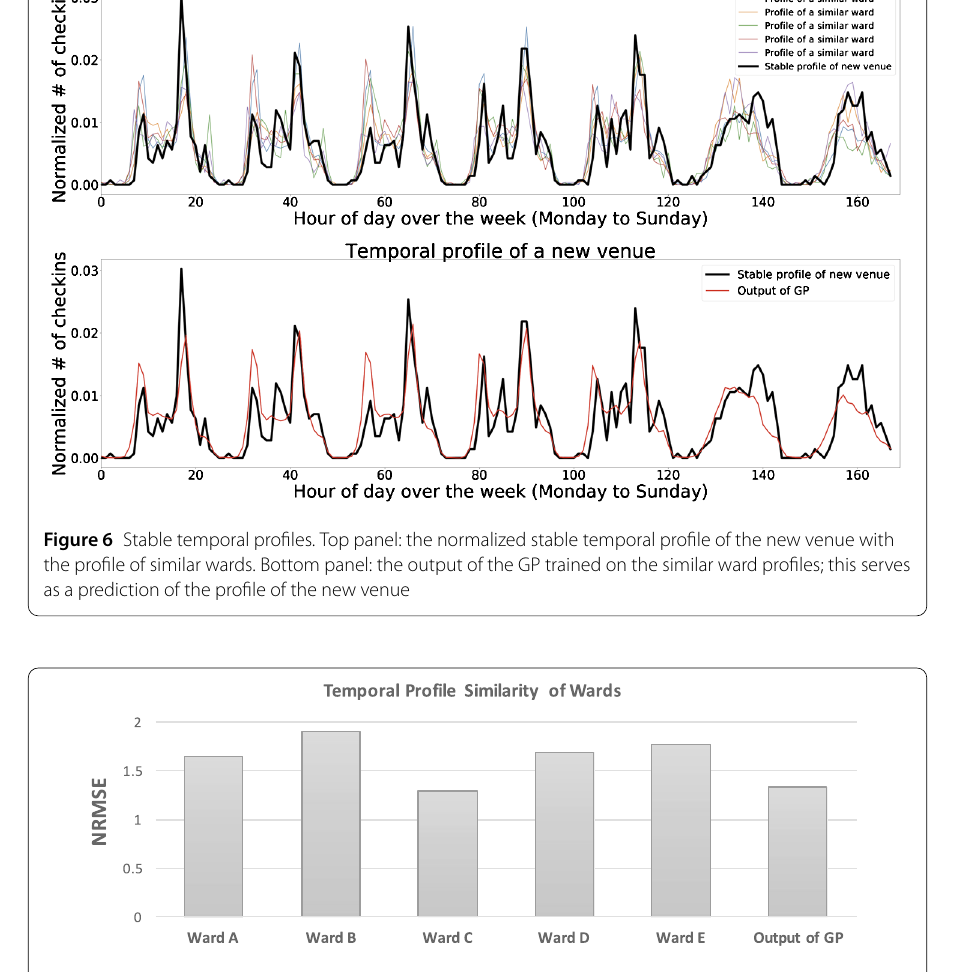
Figure 7 Profile similarity of different wards. The NRMSE between the stable temporal profile of the new venue and the temporal profile of five similar wards. “Output of GP” is the NRMSE between the output of